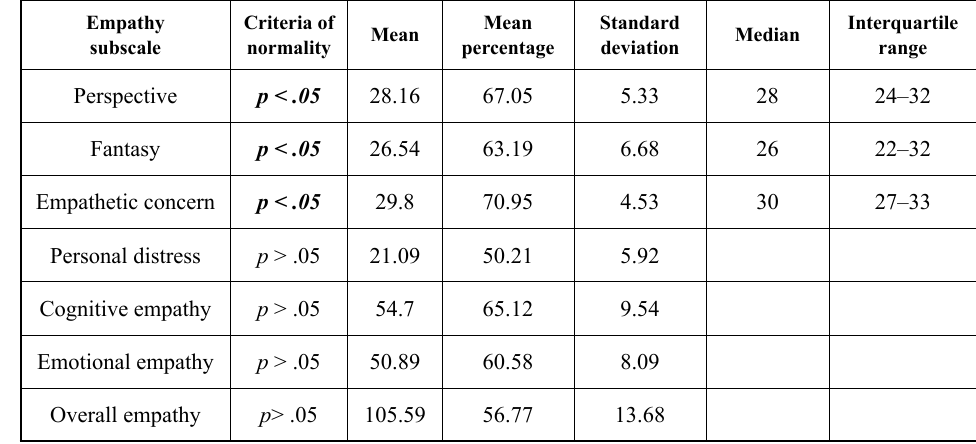
Table 4. Descriptive statistics of Subscales of Interpersonal Re - activity Index